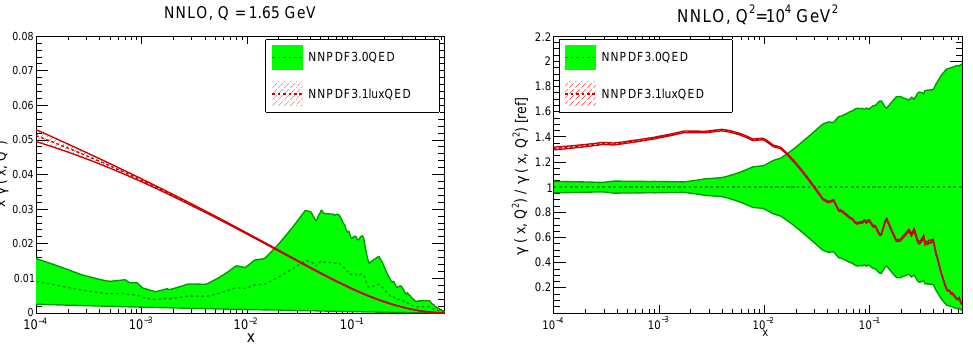
Figure 3.3: Comparison between the photon PDF γ ( x , Q ) in NNPDF3.0QED and in NNPDF3.1luxQED at Q = 1.65 GeV (left) and at Q = 100 GeV (right plot). In the latter case, results are normalised to the central value of